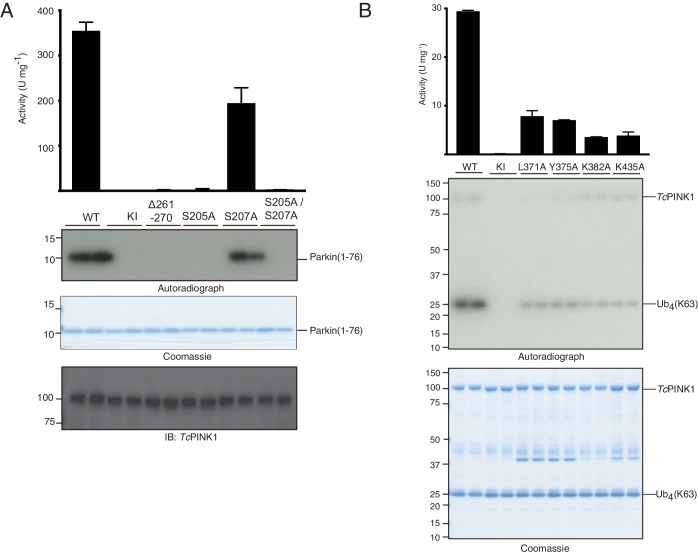
TcPINK1 Mutations in Ins3, autophosphorylation site and canonical substrate binding region result in loss of activity.(A) Parkin Ubl phosphorylation assay with full-length TcPINK1 (WT), kinase-inactive D359A mutant (KI), Ins3 deletion (∆261–270), S205A, S207A and S205A/S207A. 30 ng of indicated enzyme was incubated in the presence of 2 μM Ubl domain of Parkin (1-76) and [y-32P] ATP for 10 min. Reactions were terminated by addition of SDS sample buffer and separated by SDS-PAGE. [γ-32P] incorporation visualised by autoradiography (upper panel), followed by Cerenkov counting of substrate bands for quantification (top panel), Western blot against TcPINK1 (lower panel) and Coomassie-stained gels showing Ubl (middle panel) are used as loading control. (B) Ubiquitin phosphorylation assay with TcPINK1 (WT), kinase-inactive D359A mutant (KI), and canonical substrate-binding mutants L371A, Y375A, K382A, and K435A. 2 μg of indicated enzyme was incubated in the presence of 2 μM ubiquitin (K63-linked tetraubiquitin), and [γ32-P] ATP for 10 min. Reactions were terminated by addition of SDS sample buffer and separated by SDS-PAGE. Gels were analysed by Coomassie staining (lower panel) and [γ-32P] incorporation visualised by autoradiography (middle panel), followed by Cerenkov counting of substrate bands for quantification (upper panel).